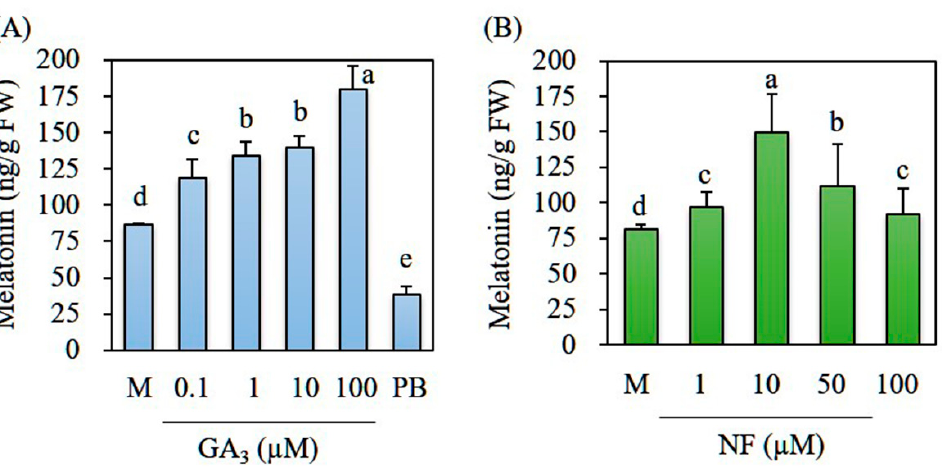
Figure 2. Dose-dependent melatonin levels in response to ( A ) GA 3 and ( B ) norflurazon. Various concentrations of GA 3 or NF were used to rhizospherically treat to 7-day-old rice seedlings for 24 h, followed by treatment with 0.5 mM cadmium for 3 days. Melatonin content was quantified using high-performance liquid chromatography (HPLC). Different letters denote significant differences ( p < 0.05; ANOVA, followed by Tukey’s HSD post hoc tests). M, water containing 0.1% ethanol; GA 3 , gibberellic acid 3; PB, pachlobutrazol; NF, norflurazon.